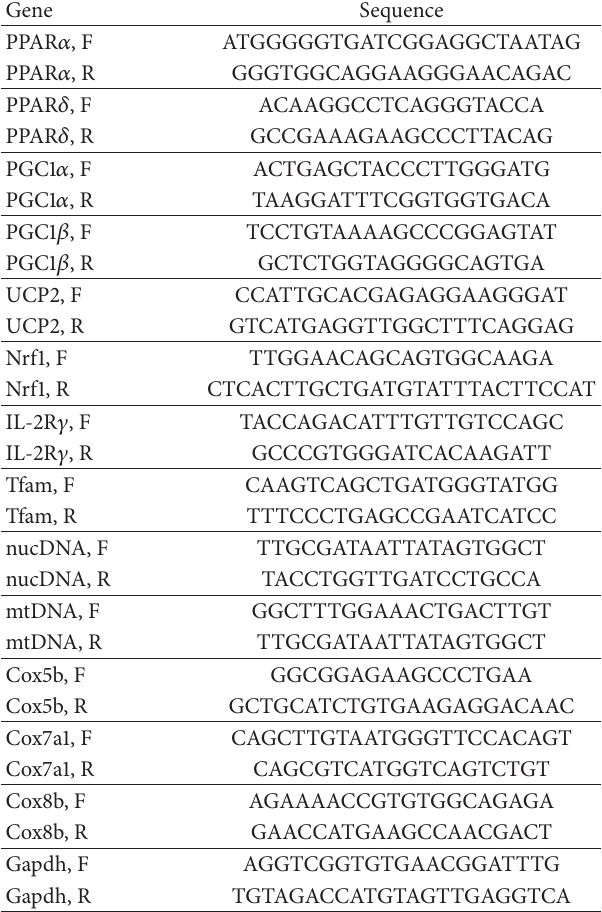
Table 1: Primer sequences used for qPCR